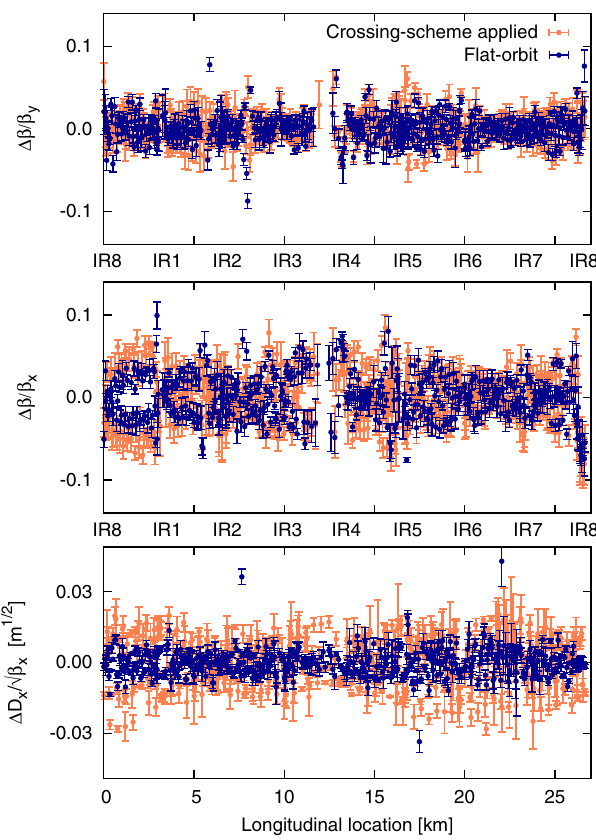
FIG. 24. Histogram of the j f 0 0030 j ac-dipole resonance driving term, related to the 3 Q y resonance, measured in LHC BPMs with and without correction of skew sextupole errors in the ATLAS (IR1) insertion.